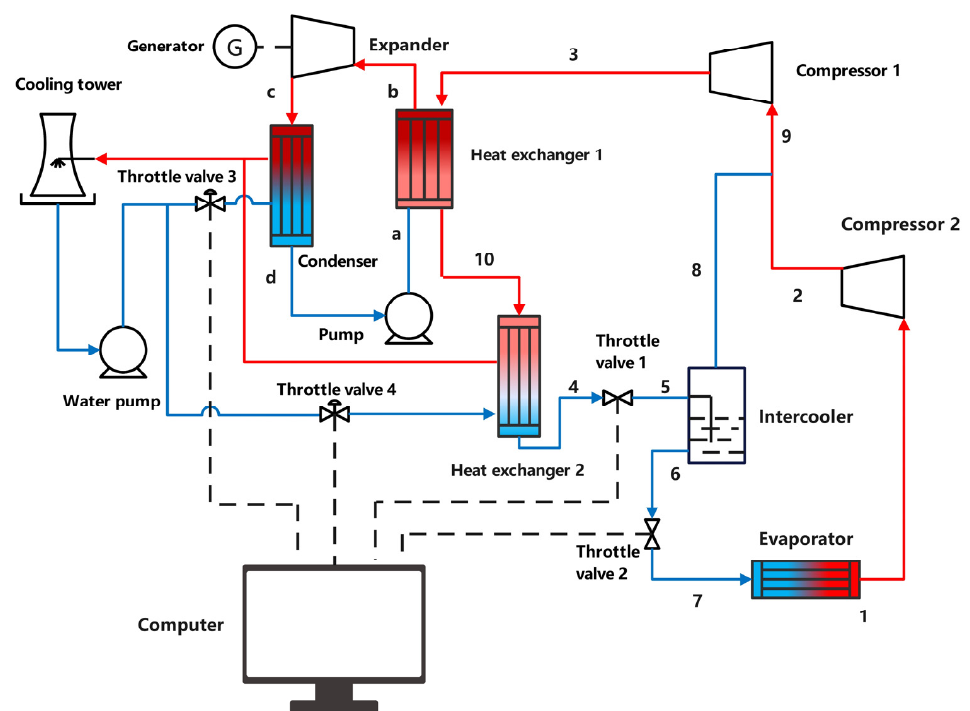
Figure 1. Schematic diagram of a CO 2 transcritical two stage compression refrigeration system based on an ORC system.